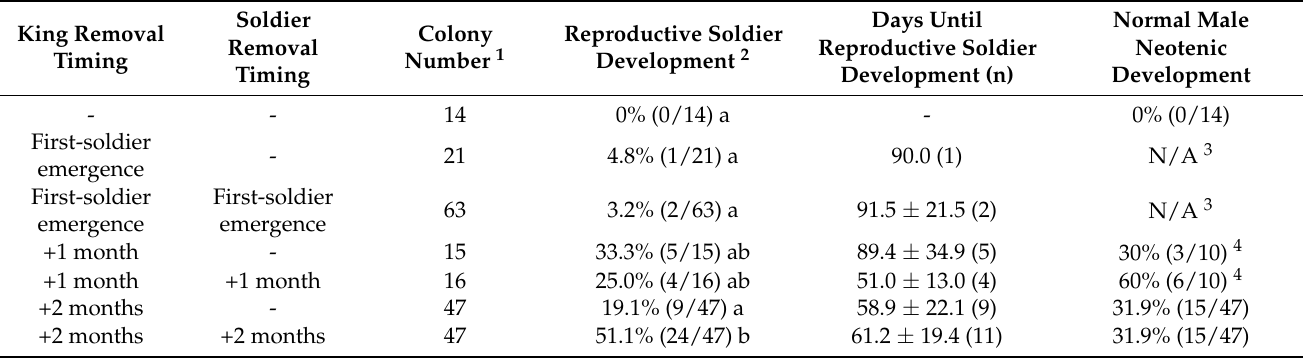
Table 1. Rates of colonies with reproductive soldiers or neotenics after each treatment.